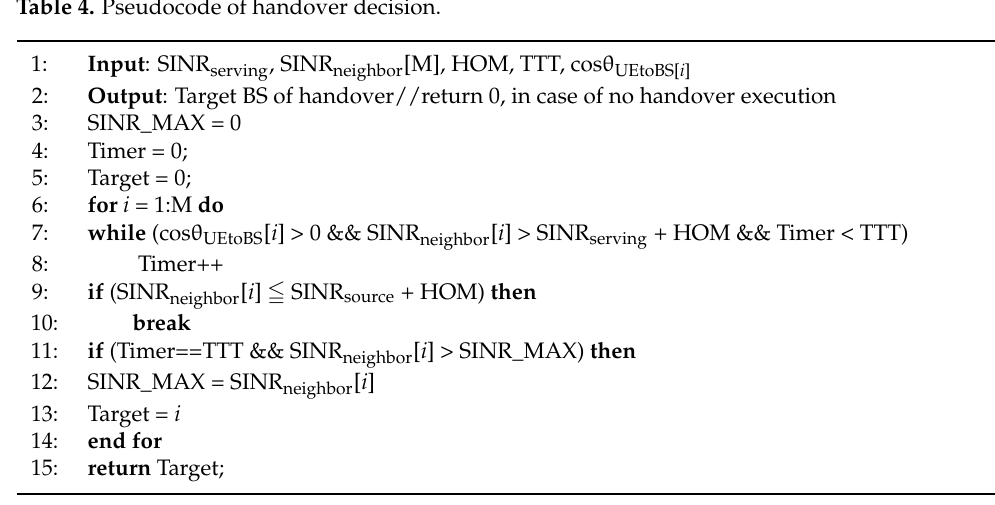
Figure 9. Membership function of linguistic TTT. Table 4. Pseudocode of handover